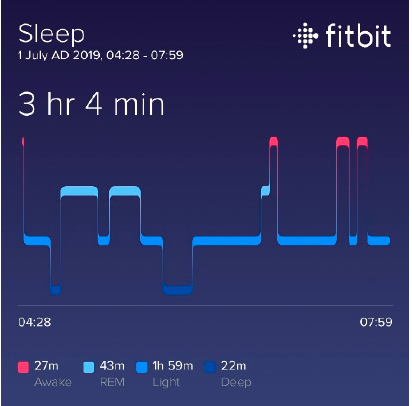
Figure A8. Nagoya, Japan.